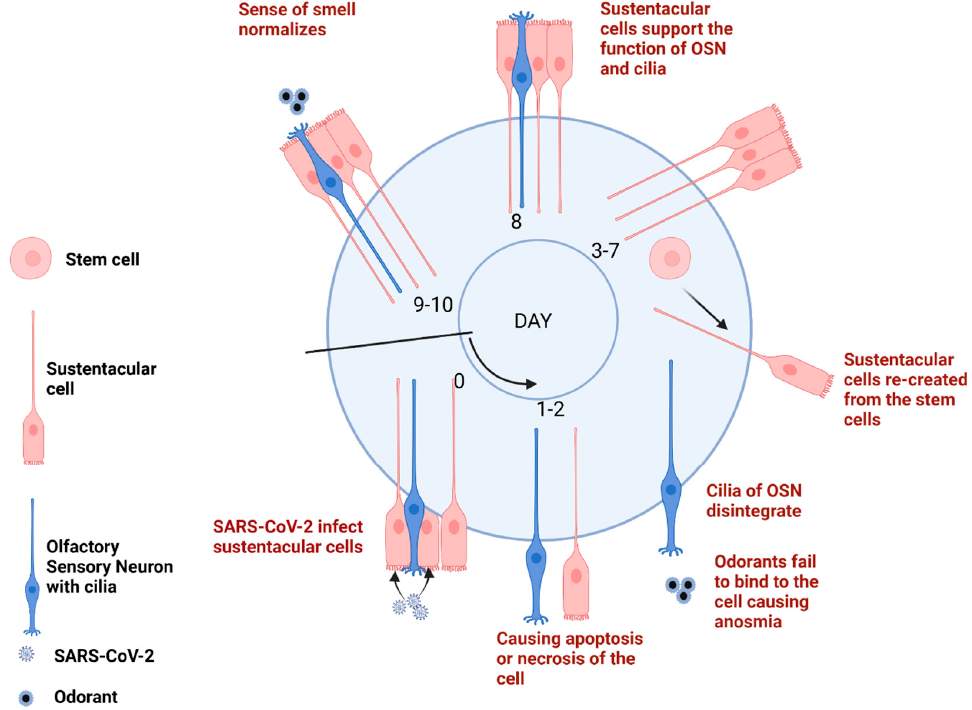
Figure 2. Temporal representation of the pathological mechanisms leading to short-term anosmia following SARS-CoV-2 infection. Created with Biorender.com (access on 1 August 2022).